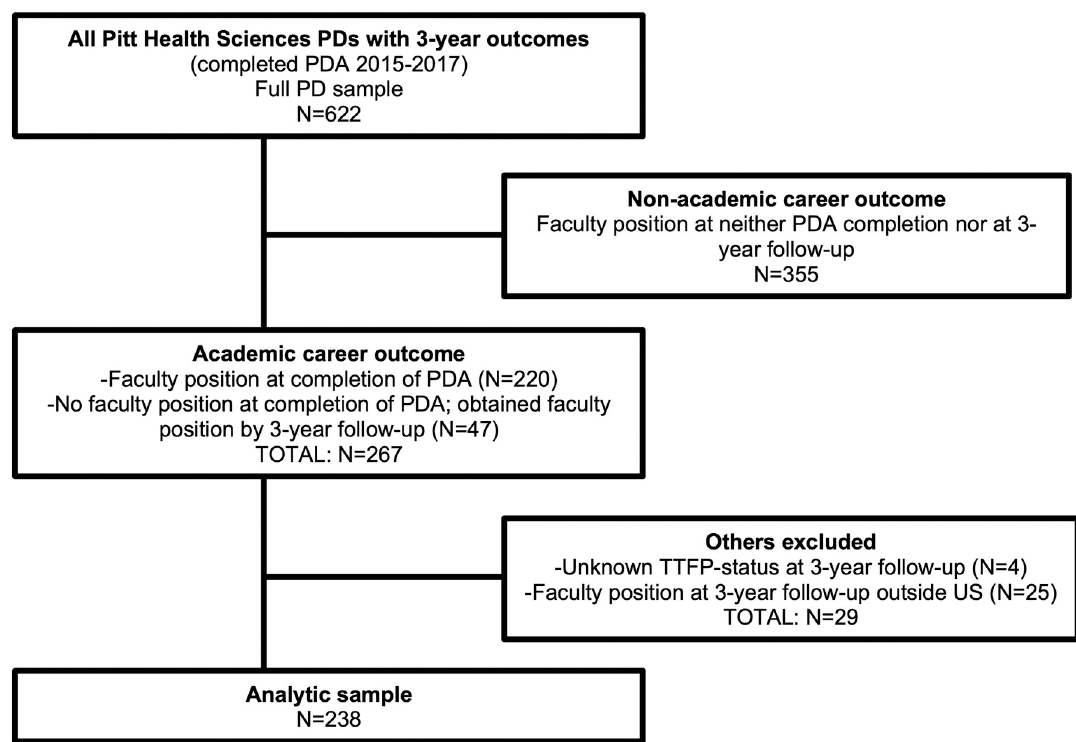
Fig 2. Inclusion of analytic sample. Note: PD = postdoc; PDA = postdoctoral appointment; TTFP = tenure-track faculty position.